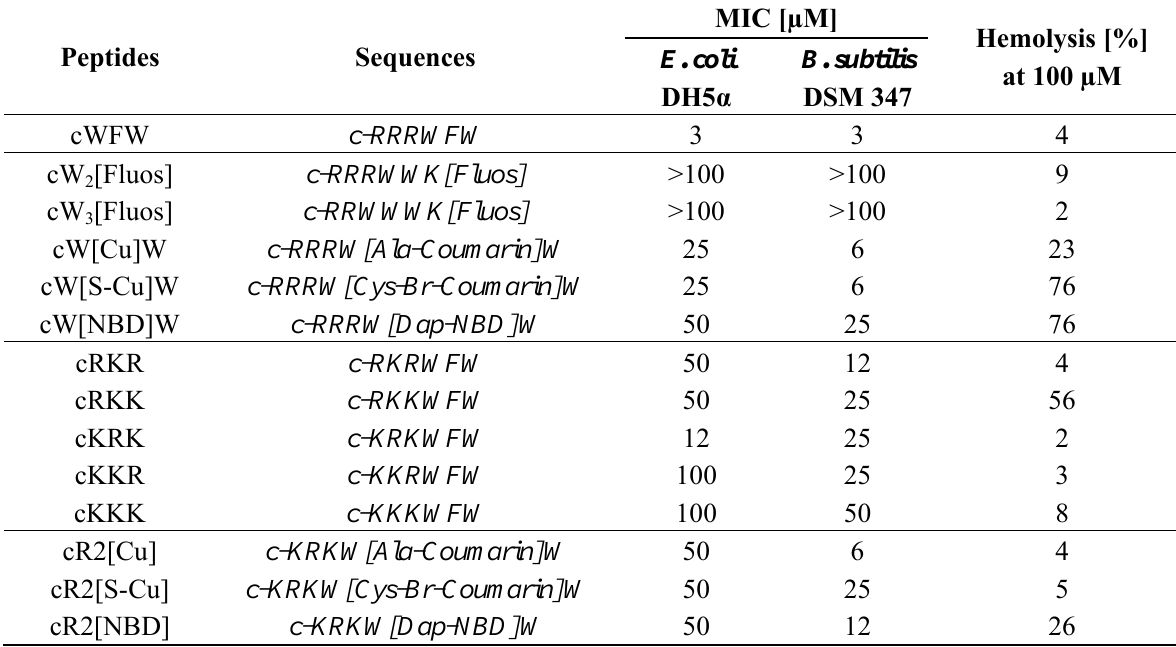
Table 1. Sequences, antimicrobial and hemolytic activity of the cylic hexapeptide analogues. Minimal inhibitory peptide concentrations (MIC) were determined in triplicates in at least three independent experiments. Hemolytic activity was determined as % hemolysis at a peptide concentration of 100